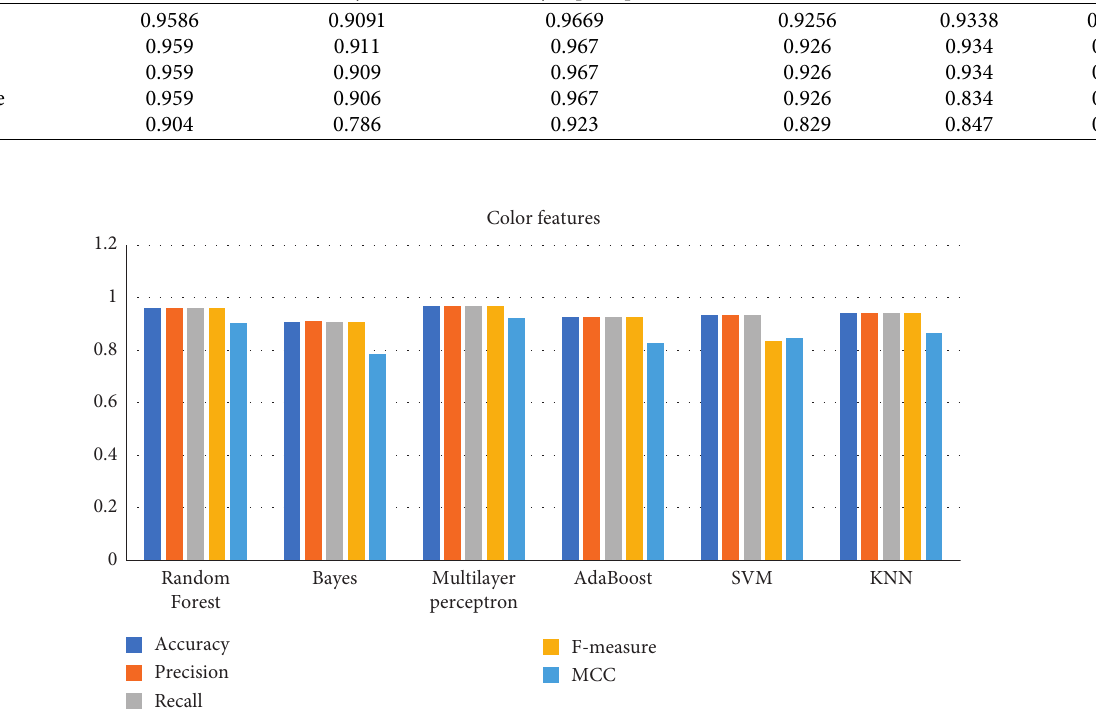
Figure 14: Classifier evaluation based on 4 color